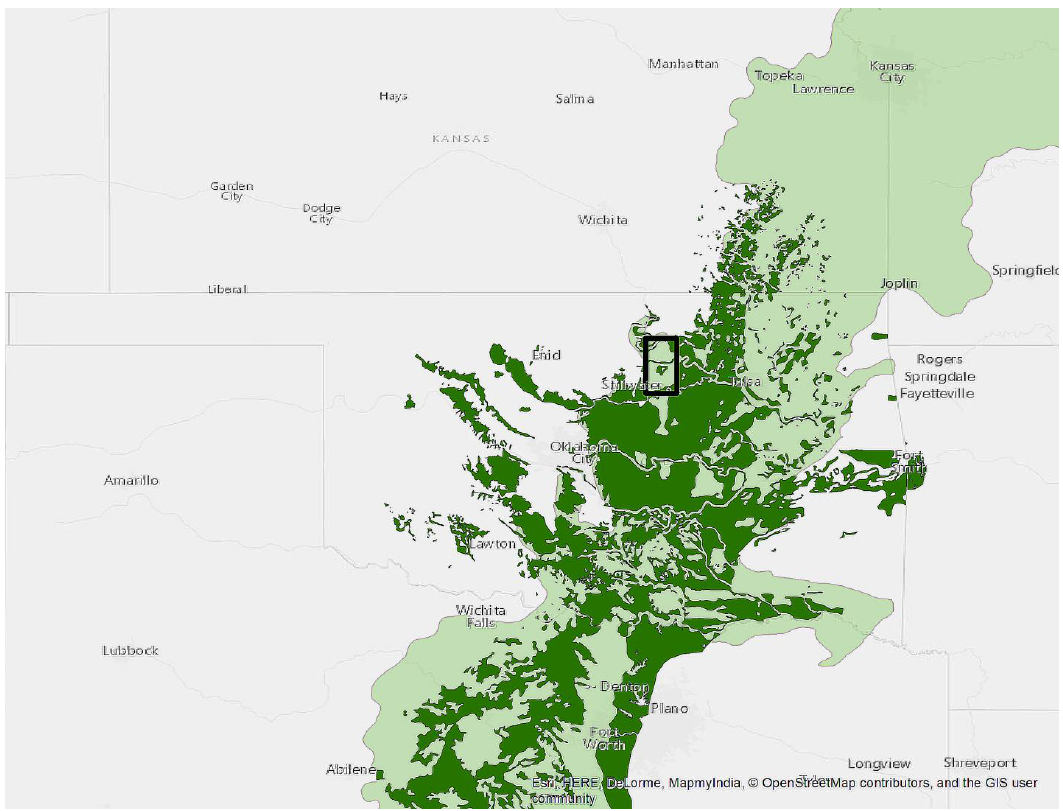
Figure 1. Study area represented by the black rectangle. The lightly shaded area is the Terrestrial Ecoregions of the World [24] designation for the transition between central forest and grasslands. The dark area represents the Cross Timbers from the Potential Natural Vegetation Type for the Continental U.S. [1]. This ecotone is commonly referred to as the Cross Timbers in Texas, Oklahoma and